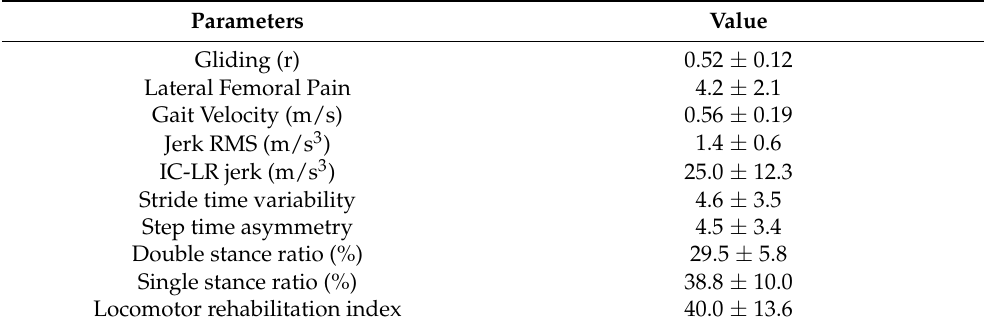
Table 1. Measurement results.